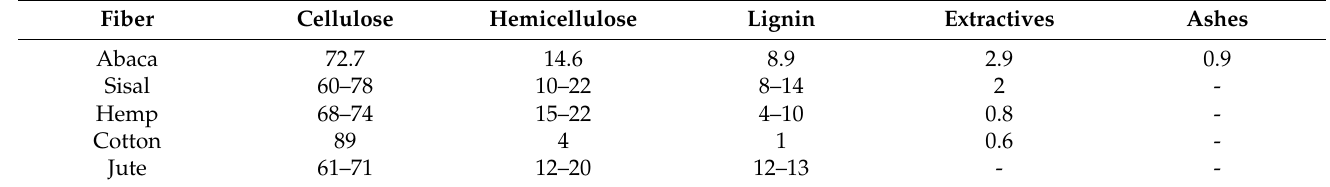
Table 1. Chemical composition of Abaca fibers and other natural fibers used as reinforcement.